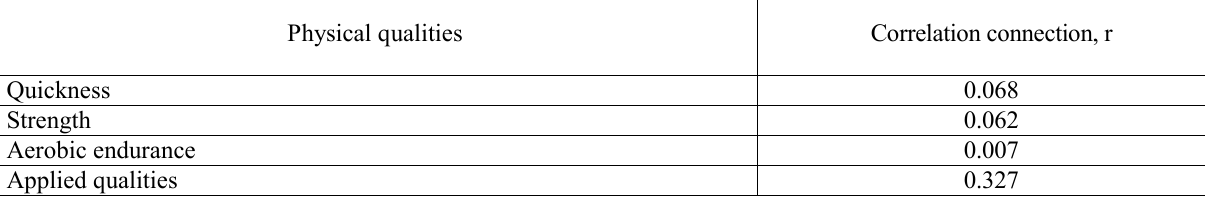
Correlation dependence of formation level of physical qualities and professional readiness of KUAF cadets 2011 (n-173) Physical